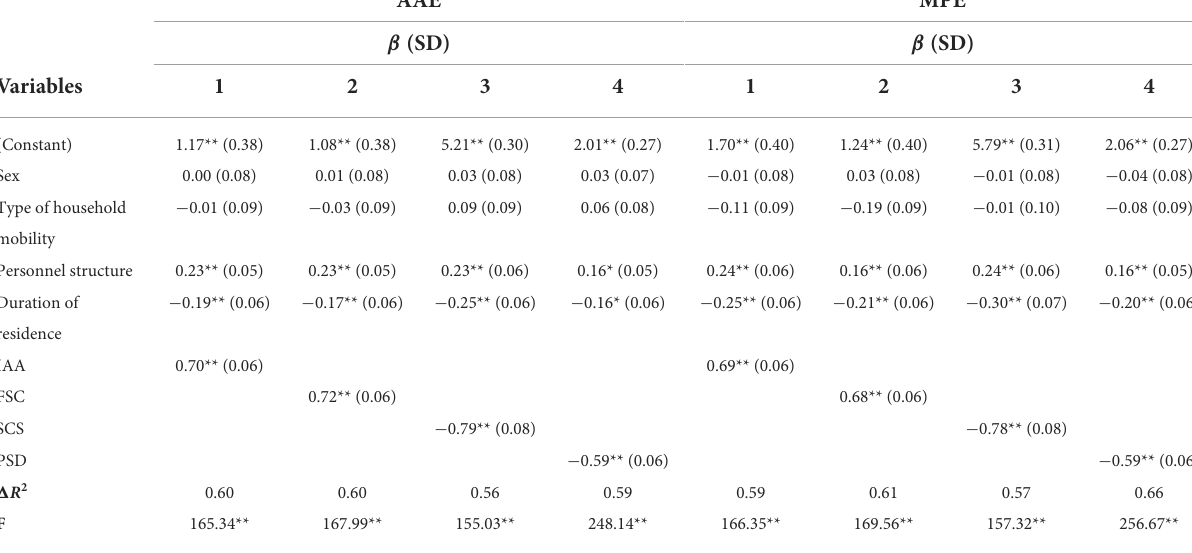
TABLE 3 Regressions results of the effect of demographic and related variables, IAA, FSC, SCS, and PSD on AAE and